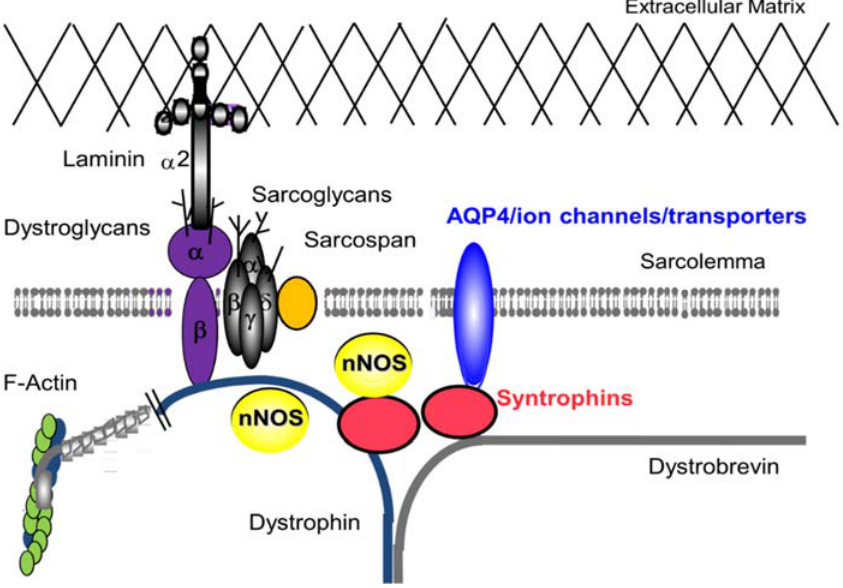
Figure 1. Dystrophin-Glycoprotein complex (DGC) in skeletal muscle. The DGC is a large multicomponent complex and has both mechanical stabilizing and nonmechanical signaling roles in skeletal muscle and in other